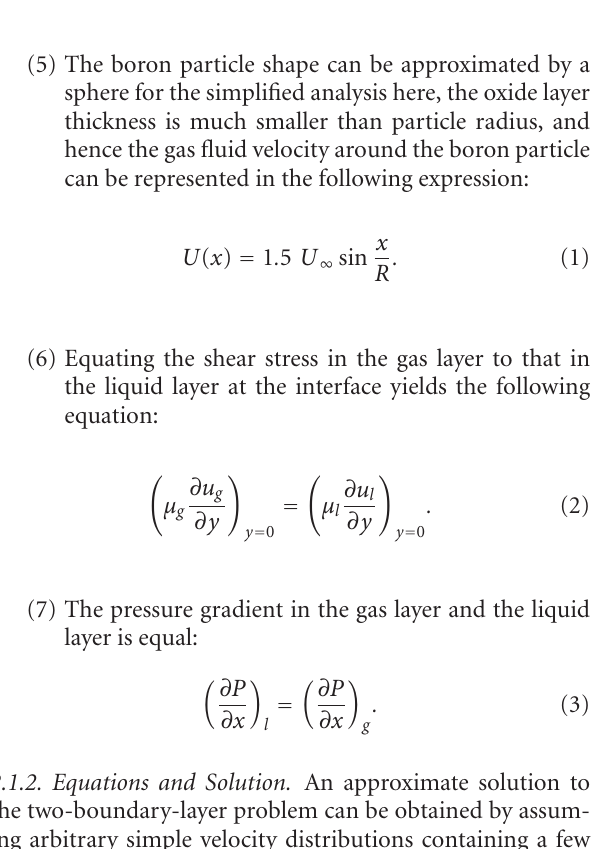
Figure 1: Scheme of oxide layer movement relative to surface of flowing boron